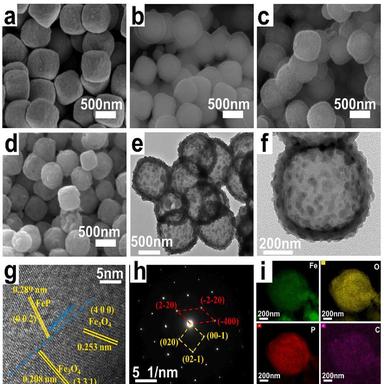
SEM images of (a) Fe2O3, (b) Fe3O4@C, (c) Fe3O4/FeP@C and (d) FeP@C. (e, f) TEM images, (g) HRTEM images, (h) HAADF-STEM images and (i) corresponding EDS mappings images of Fe3O4/FeP@C.